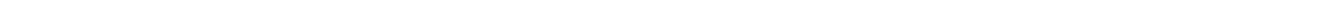
Fig. 1 Identifying critical lncRNA in ovarian cancer EMT. a Ovarian cancer patients ( n = 320) with genomic and molecular pro fi ling data that classi fi ed into epithelial (Epi; n = 231) or mesenchymal (Mes; n = 89) subtypes were selected for analysis. b Heatmap of 386 genes that were differentially expressed in the mesenchymal subtype compared with the epithelial subtype. c Inferring deregulatory programs from ovarian cancer pro fi ling data. Change in mRNA expression is modeled as linear function of the gene ’ s DNA methylation, copy number, and lncRNA expression. d , e Systematic prediction of EMT-linked lncRNA from the lncRNA-gene association information obtained from the linear model. d The lncRNA that had signi fi cantly enriched association with the differentially expressed genes ( n = 25, red dots; top 5 lncRNA labeled) were inferred as EMT associated. Remaining lncRNA were represented by gray dots. The X -axis with four different colors represent major annotation classes of the selected lncRNA ( n = 120). The Y -axis denotes which lncRNA had enriched association with the differentially expressed genes compared with non-differentially expressed genes. e Filtering of high con fi dence EMT-linked lncRNA ( n = 4; blue dots with labels) based on their aberrant expression ( X and Y -axis) in EMT and conservation score ( Z -axis). Gray dots represent remaining lncRNA. f Heatmap shows signi fi cantly enriched association of the inferred lncRNA with EMT-linked pathways. For d and f , P -values determined by